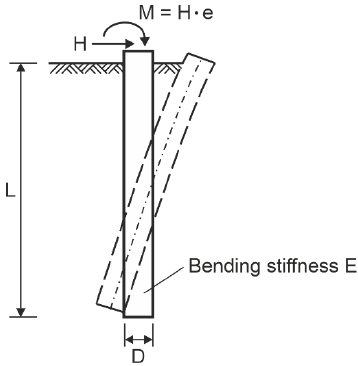
Figure 8. System and applied loading for the advanced overlay